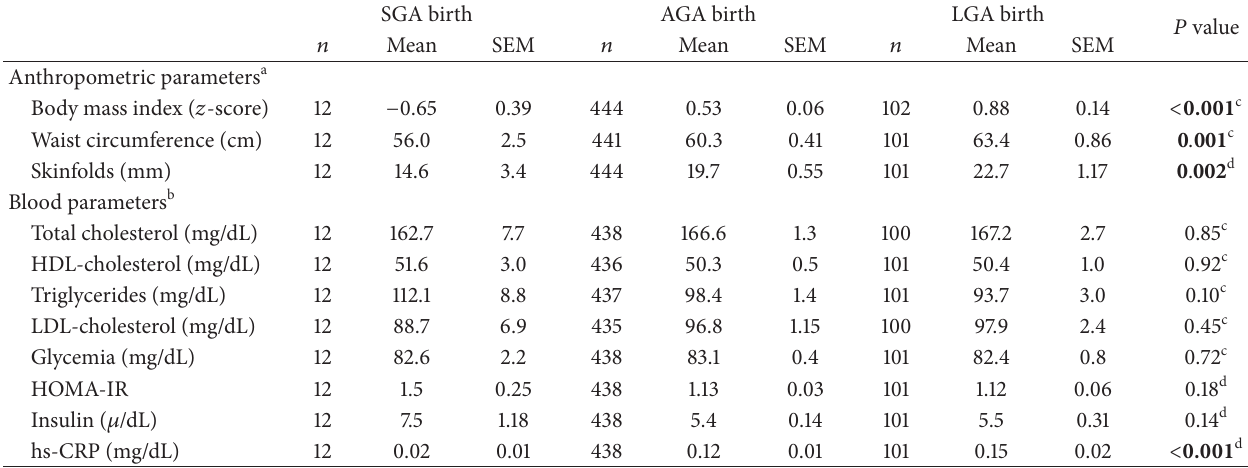
Table 3: Adjusted association between birth weight and anthropometric markers, lipid profile, glucose, HOMA-IR index, and hs-CRP in Brazilian school children ( 𝑛 = 612), 2013.